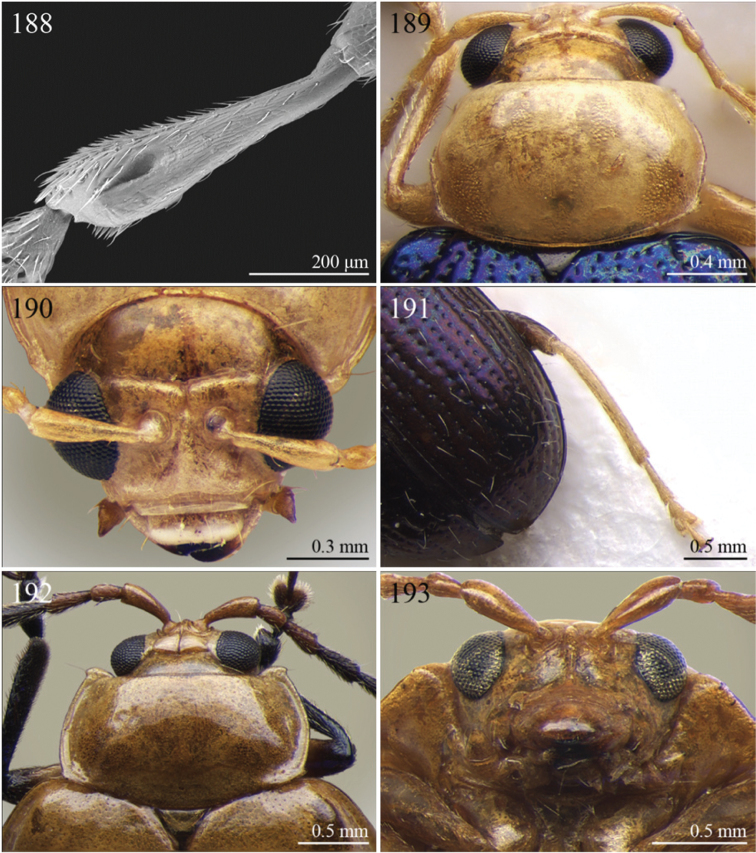
Morphological characters. 188
Guinerestia rubra Scherer, longitudinal hollow in distal half of anterior tibiae 189
Halticotropis costipennis Bechyné, head and pronotum in dorsal view 190 Ditto, head in frontal view 191 Ditto, hind leg and elytral surface 192
Hemipyxis burgeoni (Laboissière), head and pronotum in dorsal view 193 Ditto, head in frontal view.